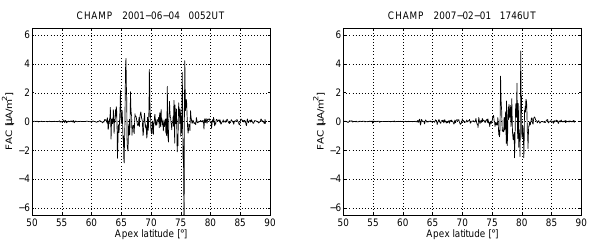
Figure 1. Two examples of FAC in the auroral oval, as derived from Fig. 1. Two examples of FAC in the auroral oval, as derived from CHAMP magnetic field data. CHAMP magnetic field data.